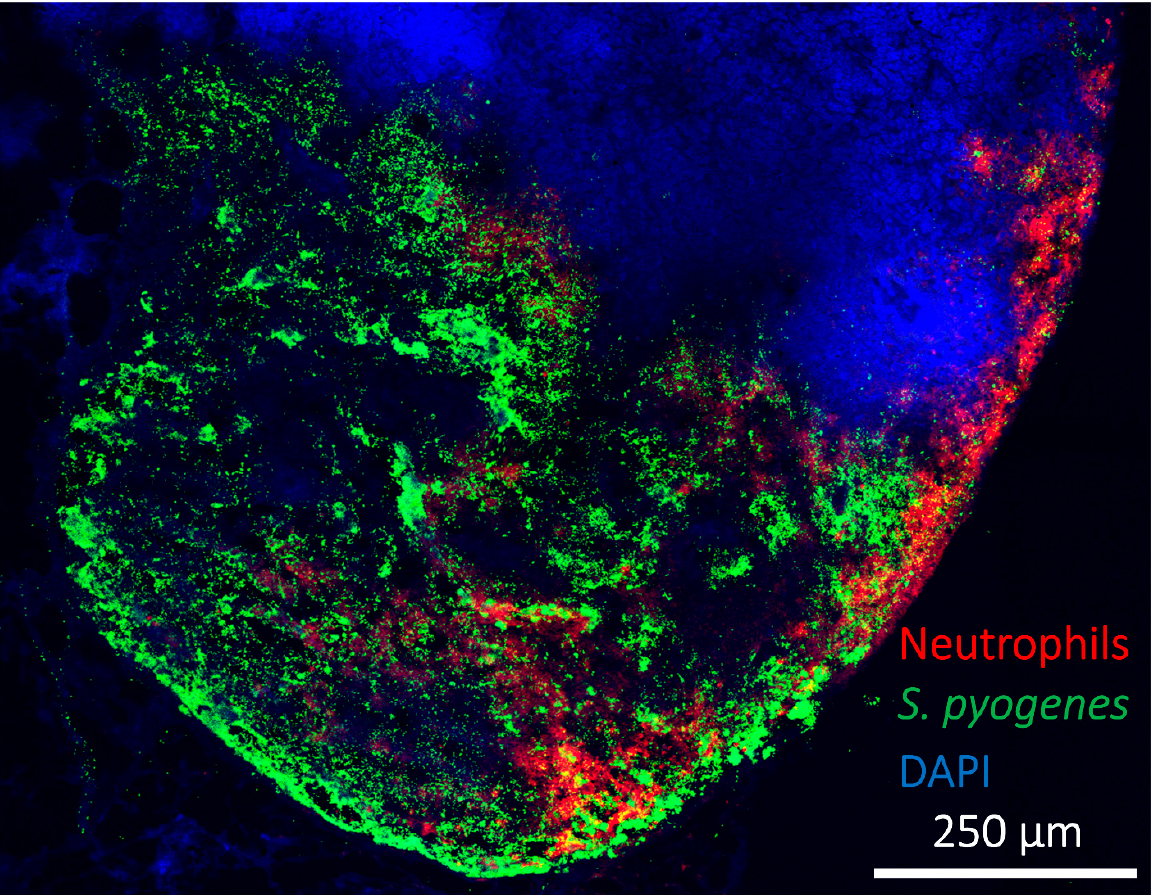
Figure 4. Expansion of virulent bacteria in a murine draining lymph node. Despite strong recruitment of phagocytic neutrophils (red), bacteria ( S. pyogenes : green) can rapidly expand from a much smaller initial population in around 24 hours post infection at a distant site (intramuscular) [21] . DAPI staining of nuclei (blue) demonstrates extensive necrotic regions, focussed in the medulla and regions of the subcapsular sinus, where bacteria are present and prominent lysis of host cells has occurred. Adapted from Siggins et al., 2020 [21] .